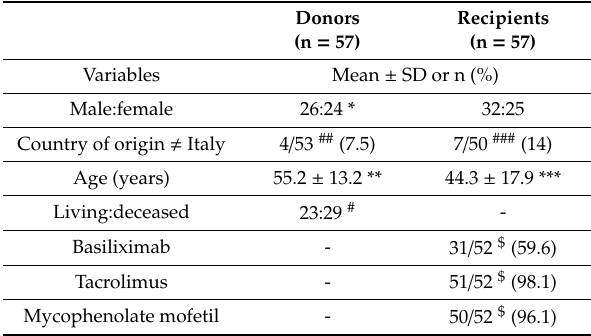
Table 1. Demographic and clinical characteristics of kidney transplant donors and